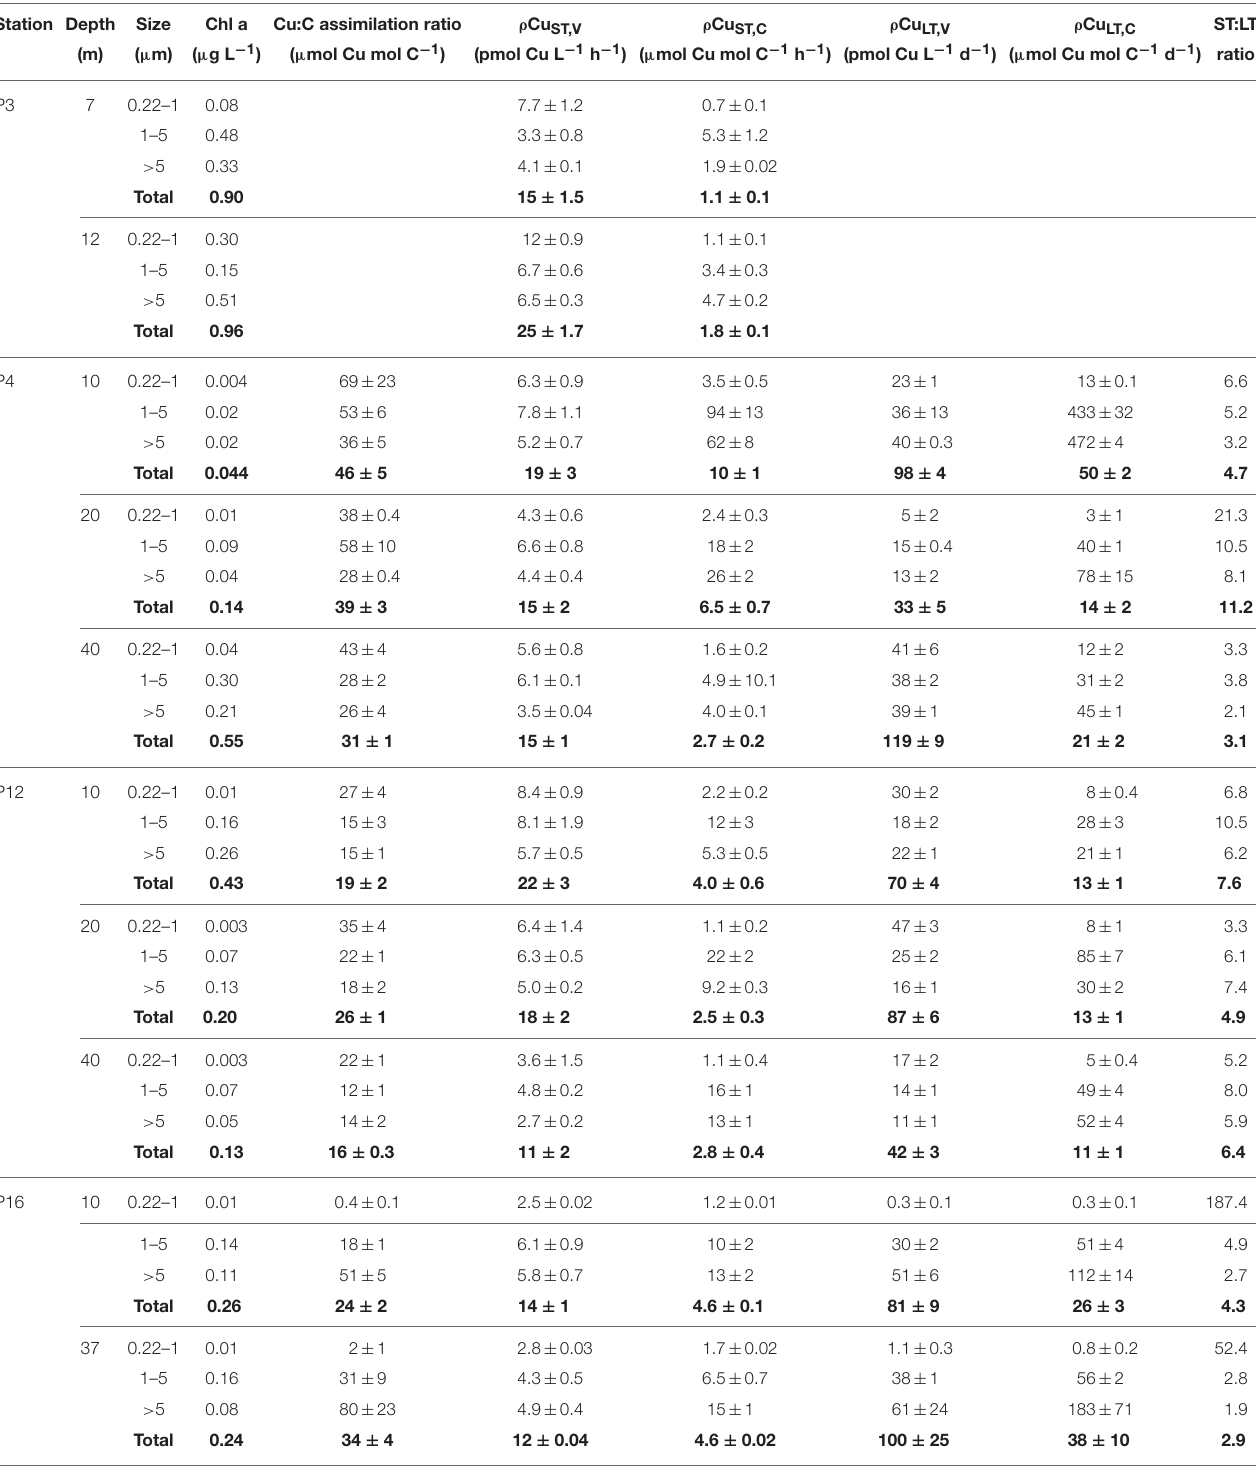
TABLE 5 | Size-fractionated Cu:C assimilation ratios (24 h), short-term Cu uptake rates (2 h), long-term Cu uptake rates (24 h), and the short-term:long-term uptake rate ratio for each sampling depth along Line P in August 2011. Station Depth